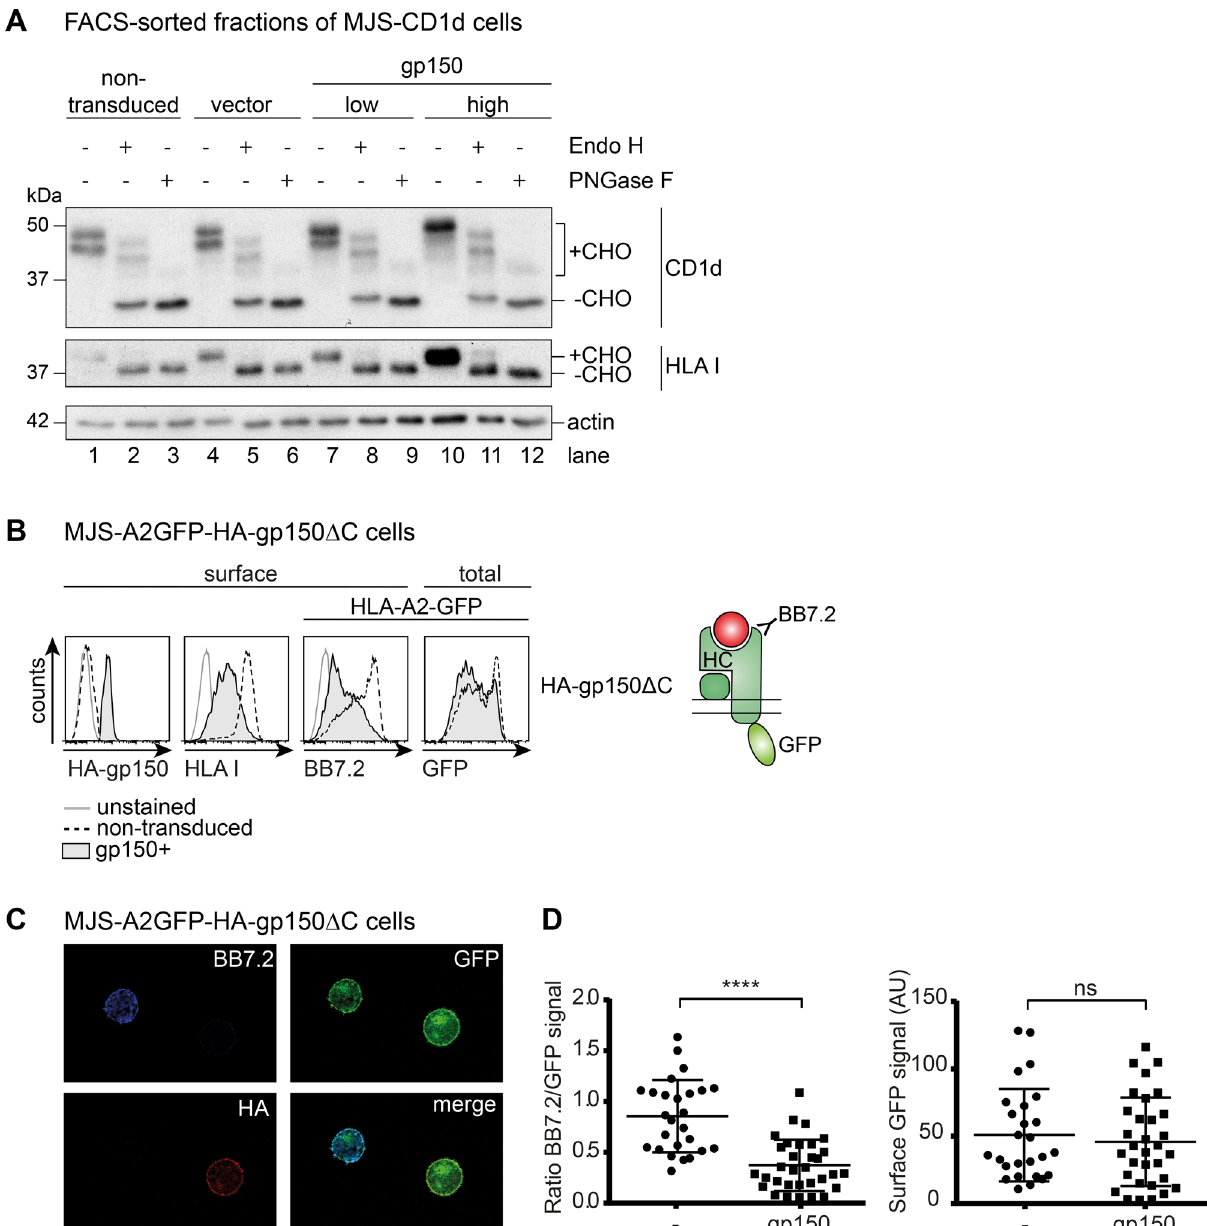
Fig 5. Immune evasion by EBV gp150 occurs at the cell surface. A) The glycosylation status of CD1d and HLA I molecules in lysates of MJS-CD1d- gp150 and control cells was analysed by Western blot. To this end, denatured post-nuclear lysates of different FACS sorted cell populations (see S4 Fig) were treated with Endo H or PNGase F to remove N-linked glycans. Endo H digestions served to examine protein transport beyond the cis-Golgi compartment; PNGase F digestions revealed the deglycosylated protein backbone (minus carbohydrates, -CHO). Actin was a loading control. B) Using the same experimental setup as in Fig 4C, MJS-A2-GFP cells were transduced with a lentivirus encoding HA-gp150 Δ C. Cell surface levels of CD1d, HLA I, and HLA-A2 (BB7.2) and total levels of HLA-A2 (GFP) were compared for (non-permeabilized) gp150 - and gp150 + cells. C) Confocal microscopy of non- permeabilized MJS-A2GFP-HA-gp150 Δ C cells. Cell surface stains were performed for HLA-A2 (BB7.2) and gp150 Δ C (HA). D) Quantification of surface expression of the indicated molecules based on multiple microscopy